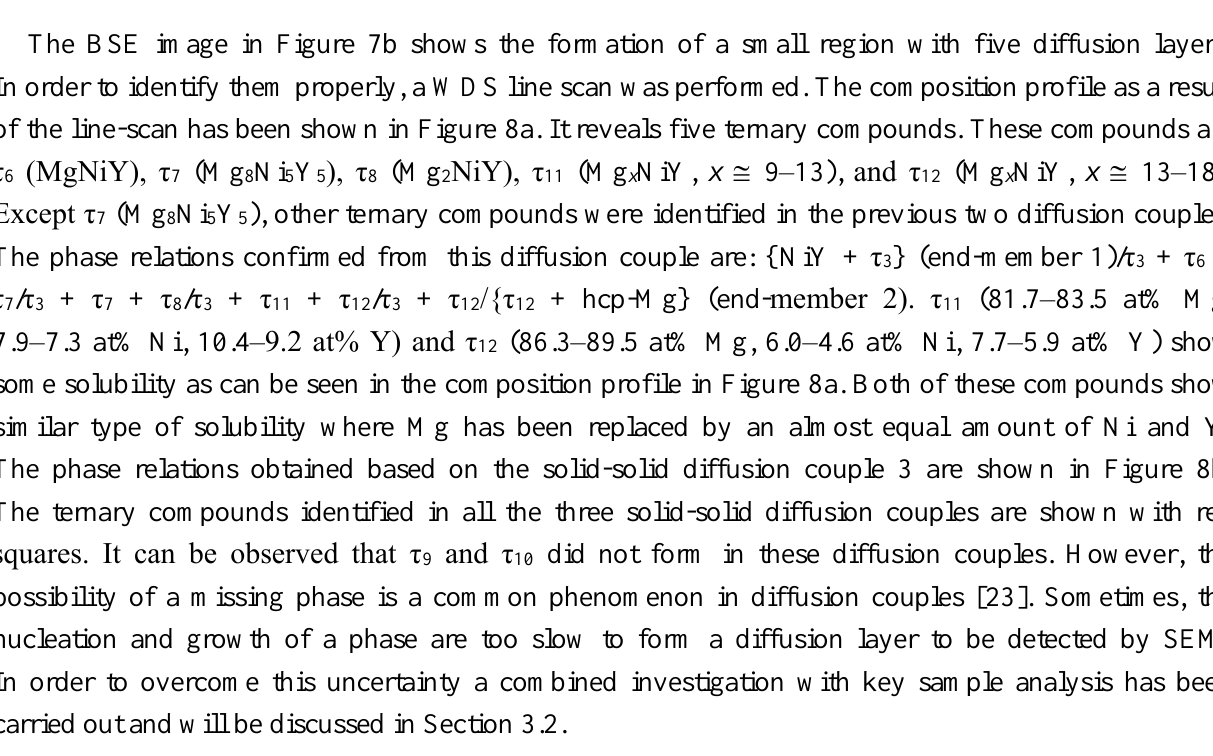
Figure 8. ( a ) Composition profile along the line scan shown in Figure 7b; ( b ) Extracted phase equilibria based on the solid-solid diffusion couple 3 projected on the Mg-Ni-Y Gibbs triangle. Dotted lines indicate expected phase equilibria which are not recognized in DC